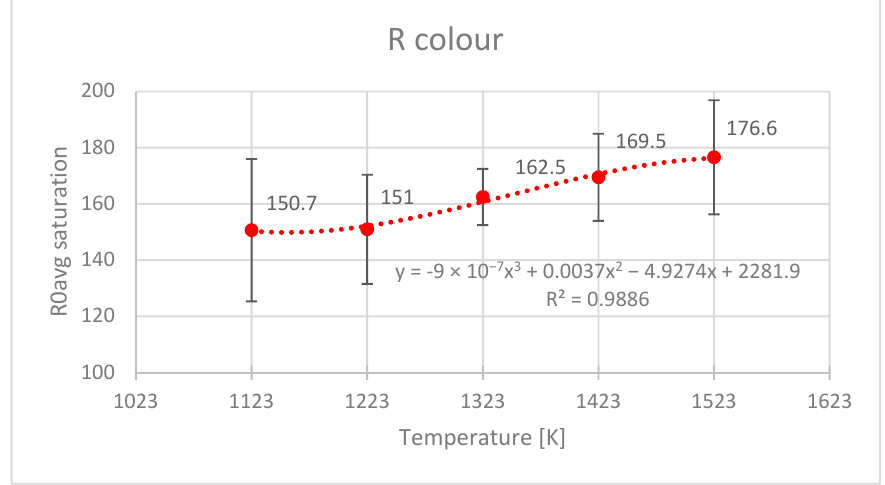
Figure 13. Mean R0 saturation of the R colour. (Reprinted with permission from Ref. [8]. 2022, AFIT).